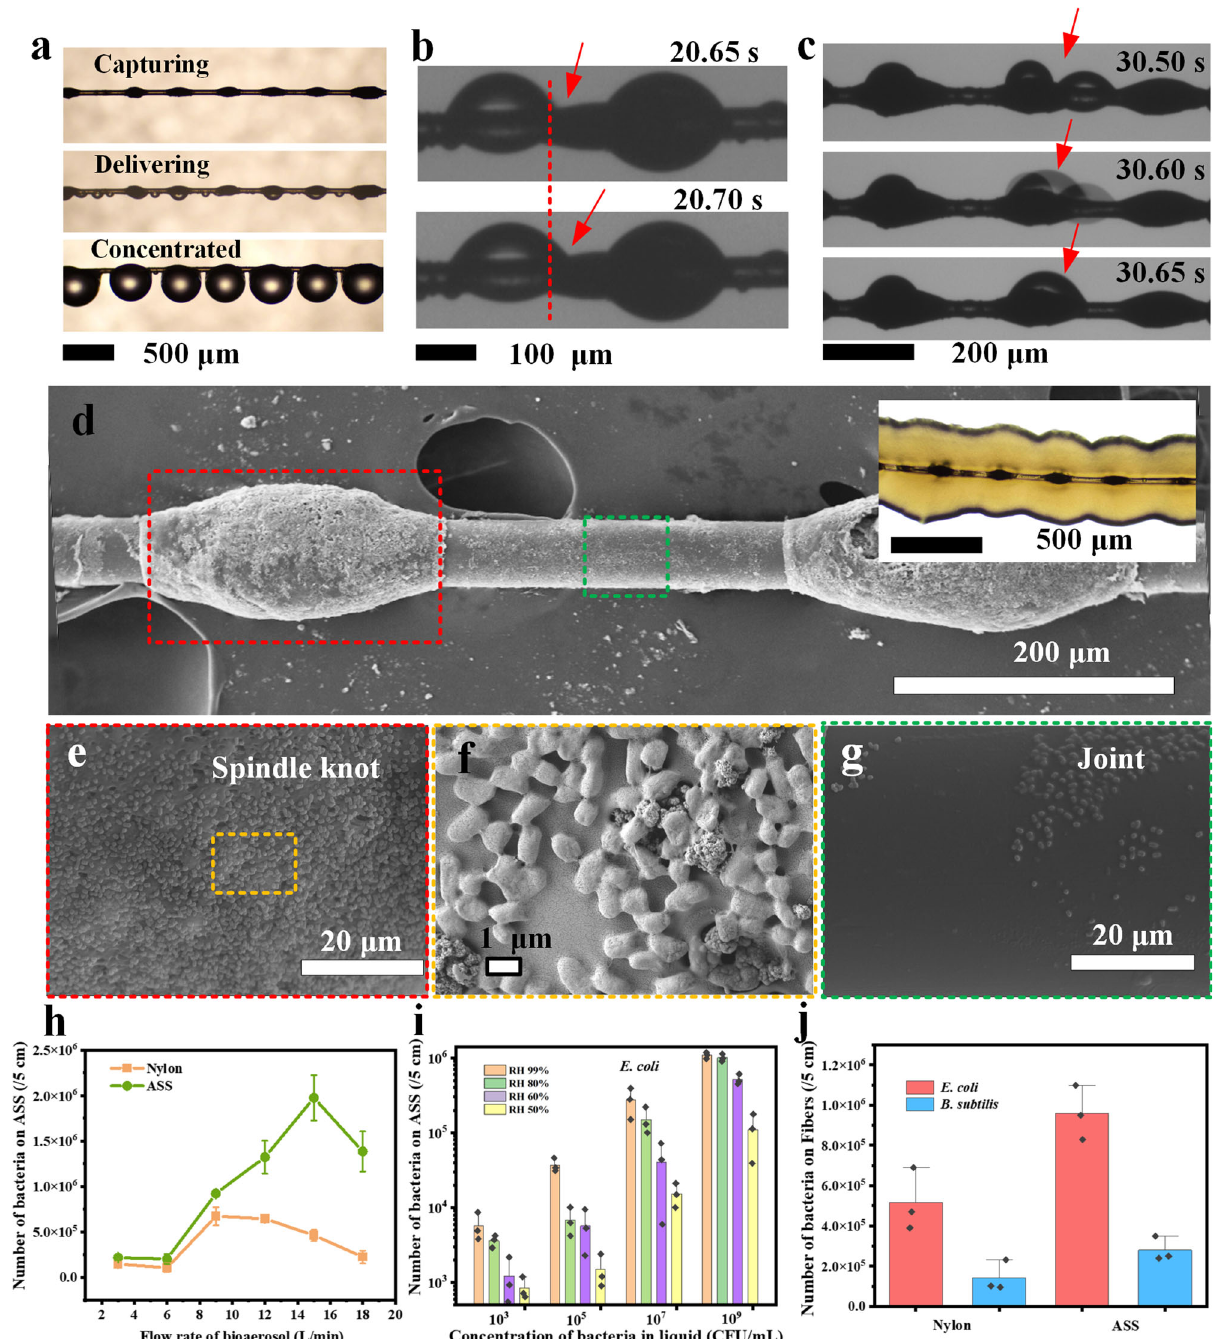
Fig. 2 | Bioaerosols capture performance of the ASS photocatalyst. a Optical imagesofbioaerosolscaptureprocessesoftheASSphotocatalyst.Opticalimageof the droplet b delivers bacteria and c converges together towards the spindle knot of the ASS photocatalyst by a high-speed camera. d SEM image of the ASS photo- catalyst that captured E. coli and the inset is optical images of bacterial colonies grownontheASSphotocatalystaftercultivation(Theindependentexperimenthas been repeated for three times, and similar results were obtained). SEM images of